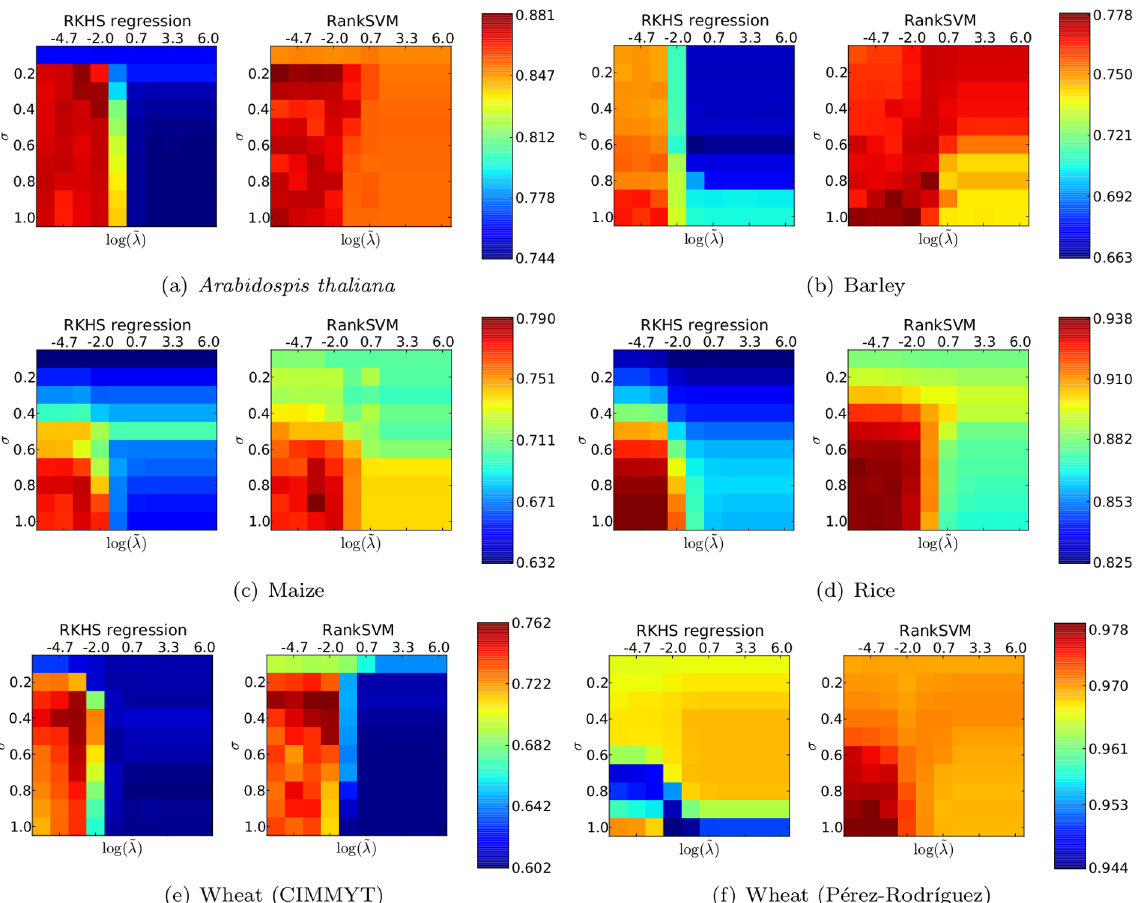
Fig 1. Comparison of RKHS regression and RankSVM when using the RBF kernel with parameter g ¼ 1 ~ l , where N = n (RKHS regression) or N = j P j (RankSVM). The scores indicated are the test Mean NDCG@10 averaged over 10 CV parameter l ¼ N iterations and across all